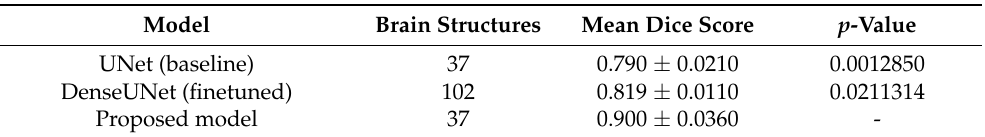
Table 2. Comparison between methods by the Dice Score and p -value for the Wilcoxon signed- rank test comparing proposed-UNet, proposed-DenseUNet samples pairs using the Mindboggle- 101 dataset.